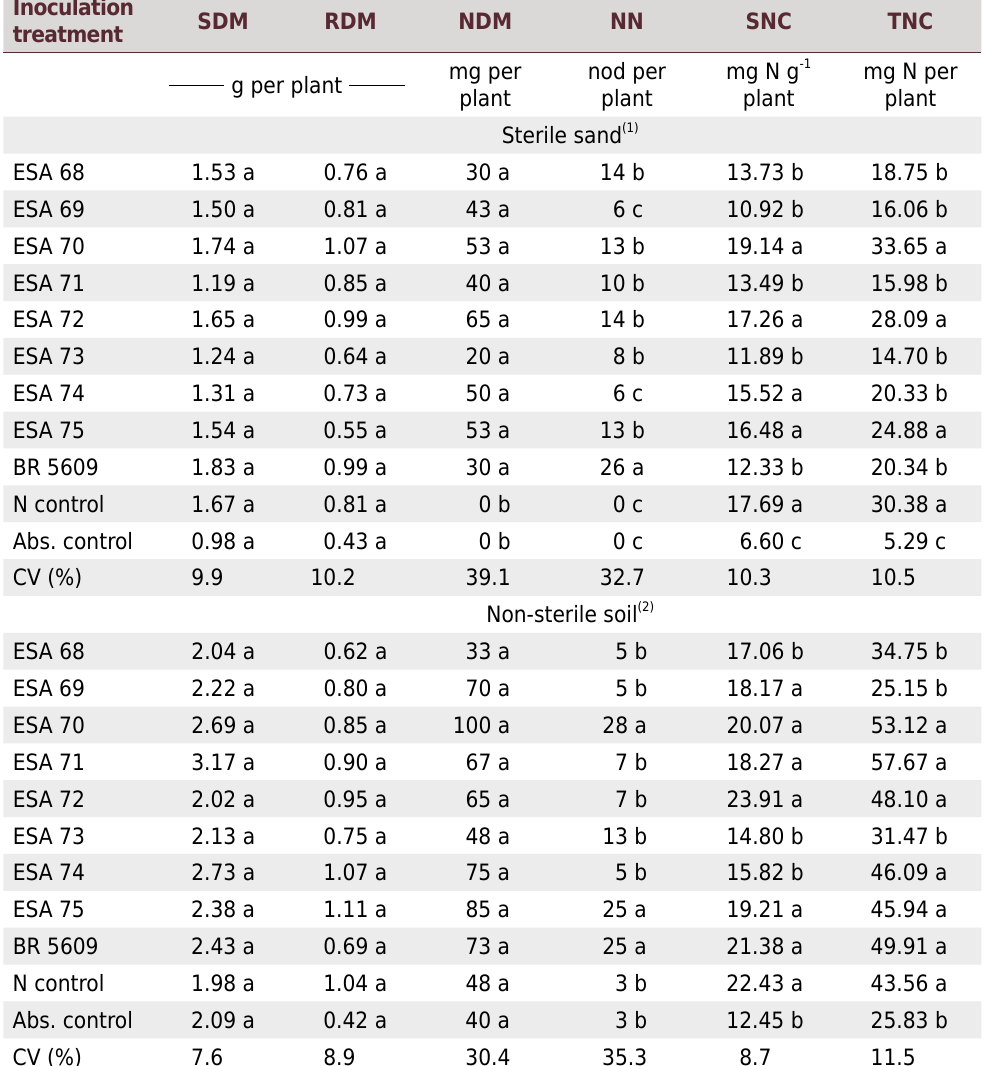
Table 1. Shoot, root, and nodule dry matter (SDM, RDM, and NDM), number of nodules (NN), shoot nitrogen concentration (SNC), and total nitrogen content (TNC) in the shoots of Erythrina velutina inoculated with different root nodule bacteria in pots experiments with sterile sand and non-sterile soil as a substrate Inoculation SDM RDM NDM NN SNC TNC treatment mg N g -1 mg N per g per plant plant